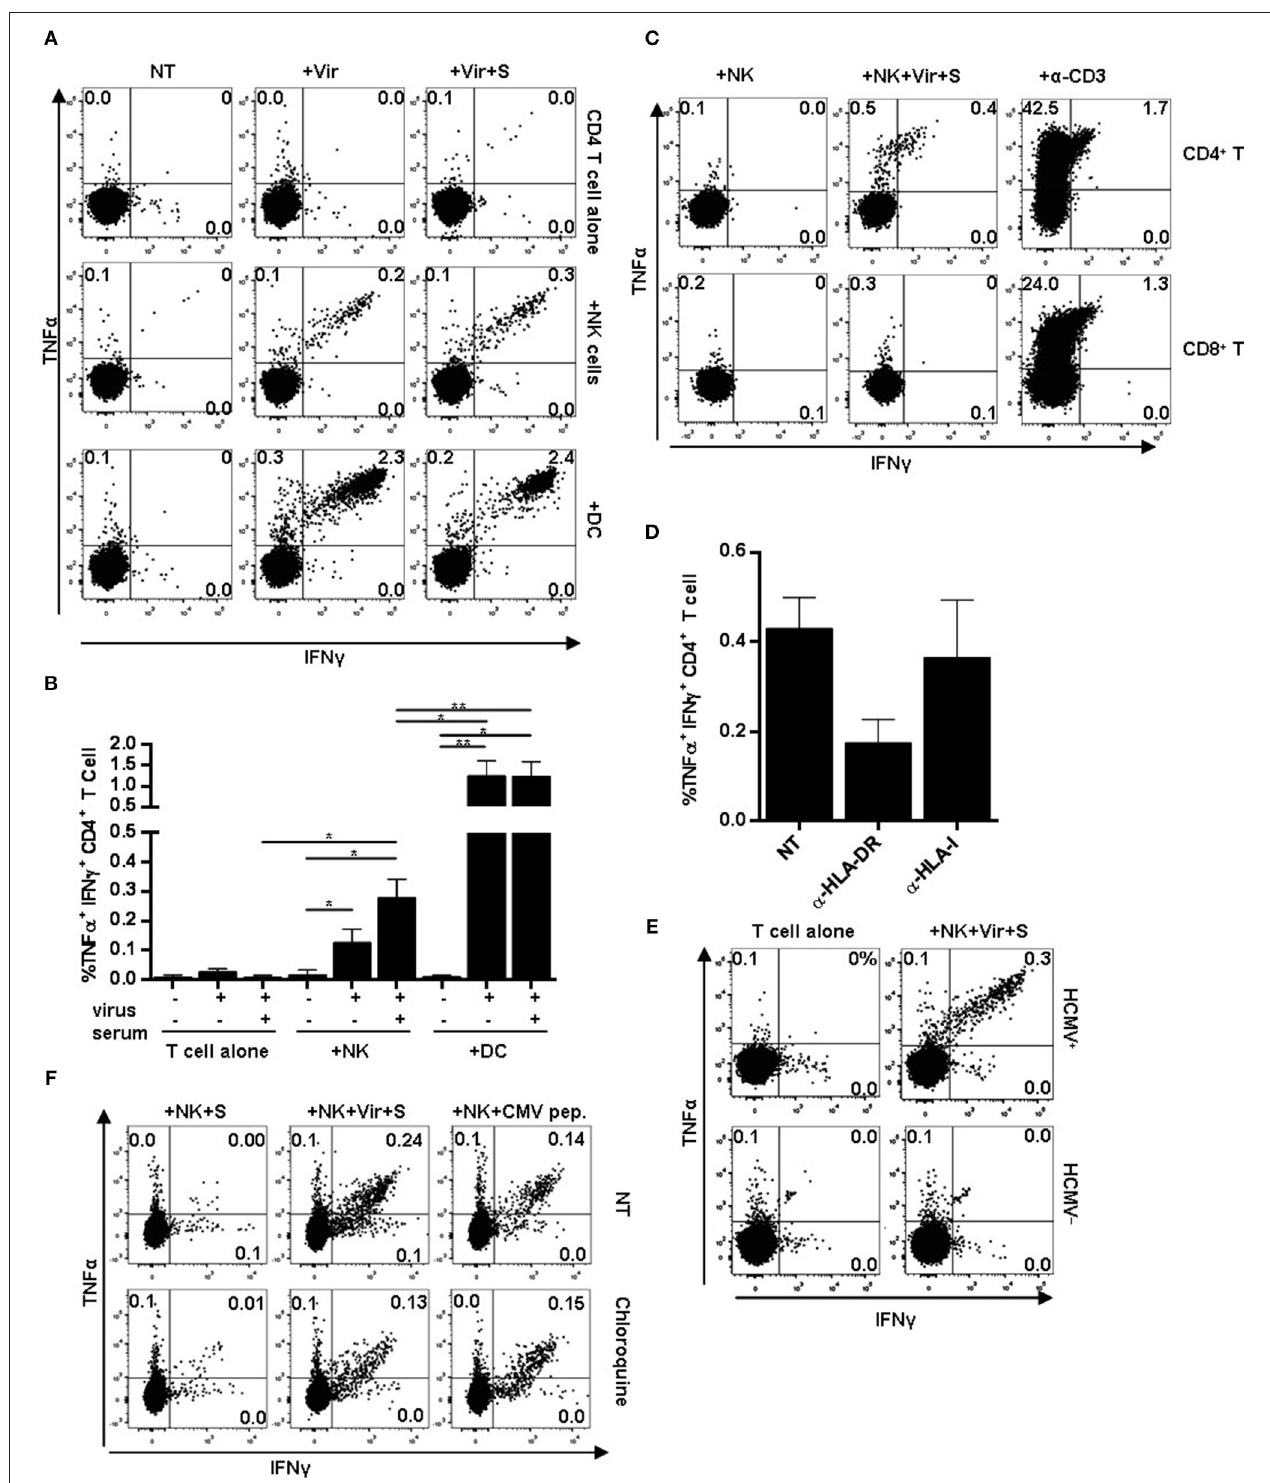
FIGURE 4 | CD4 + T cell activation in response to HCMV antigen presentation by NK or moDC. NK cells or moDCs previously loaded with HCMV-antibody immune complexes were cultured overnight with autologous CD4 + T cells. TNF α and IFN γ production was analyzed by flow cytometry. (A) TNF α and IFN γ production by CD4 + T cells in the indicated conditions. Data from a representative donor out of five tested. (B) Mean frequency of IFN γ + and TNF α + CD4 + T cells upon activation with different APCs (mean ± SEM, n = 5) (* p < 0.05, ** p < 0.01). (C–E) Autologous PBMC were used as effectors in co-culture experiments with NK